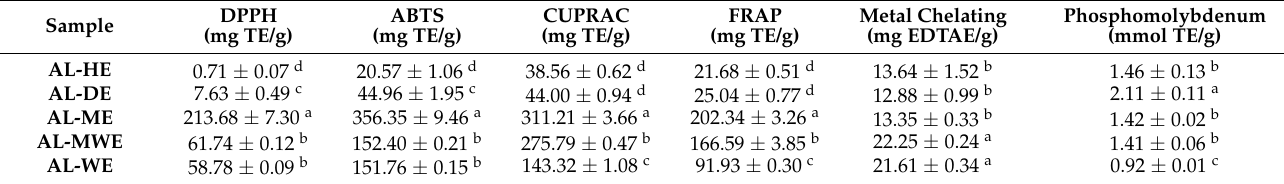
Table 3. The antioxidant activity of Artemisia campestris subsp. lednicensis extracts.